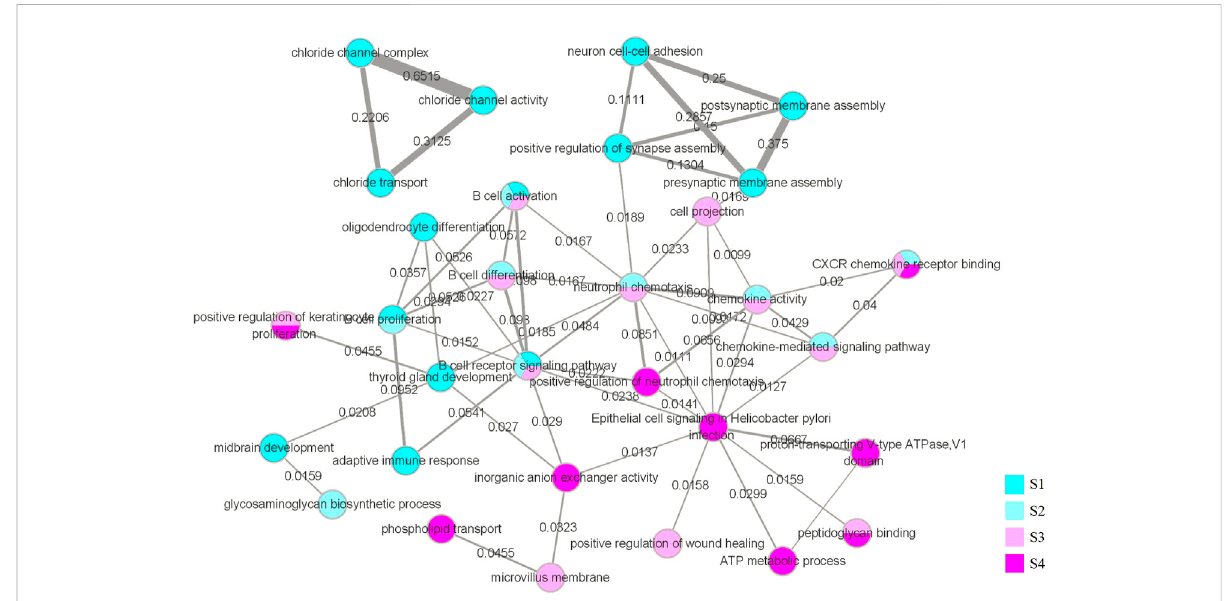
FIGURE 10 Functional interaction network. The vertices in the network represent the biological functions we obtained through GSEA and selection. The color of the vertices represents the stage in which we obtained the function, and vertices with multiple colors indicate that the corresponding function appears in multiple stages. Using the DAVID database, we obtained all the genes corresponding to the biological functions, and the edges represent that the same genes corresponding to the two biological functions have an intersection. The weights on the edges and the width of the edges represent the value of the Jaccard coef fi cient of the two groups of genes corresponding to the two biological